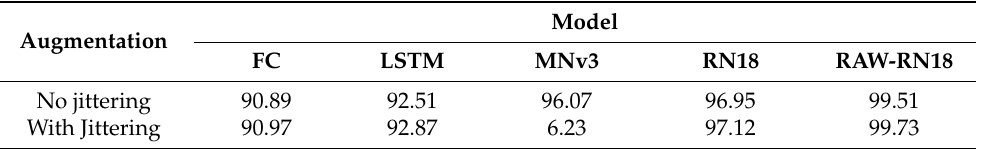
Table 2. Comparison of performance of all raw data models with and without jittering. The metric used is mean average precision (mAP). Model Augmentation FC LSTM